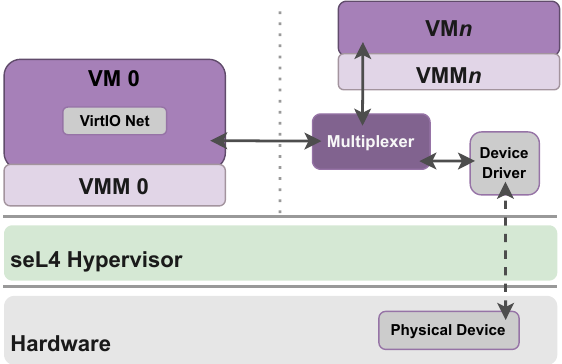
Figure 6. VirtIO interfaces considering a formally verified Device